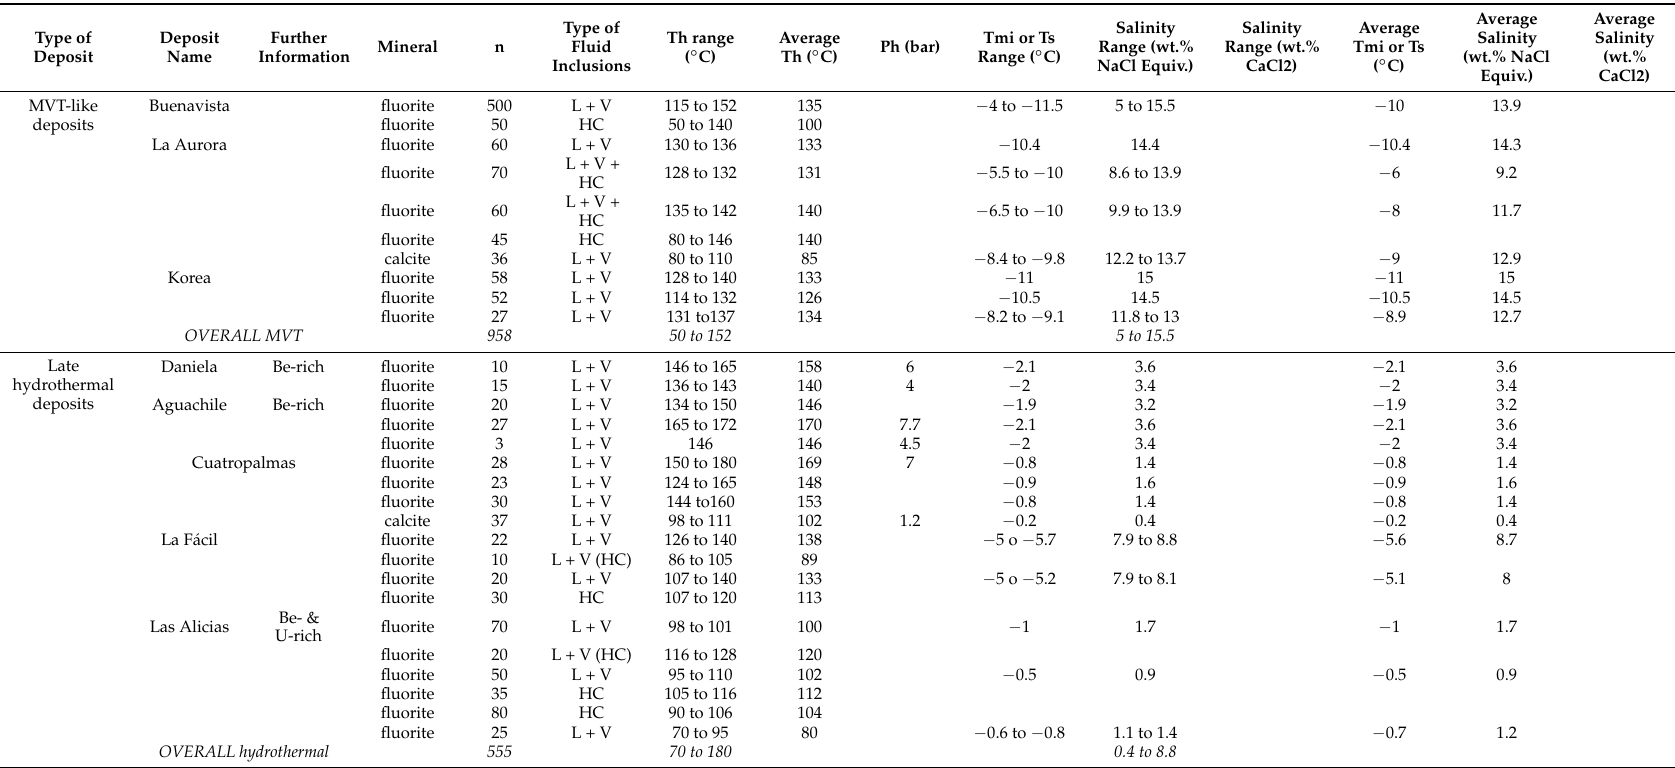
Table 1. Summary of fluid inclusion data from hydrothermal fluorite–Be–U–Mo–P–V deposits in the Aguachile–Cuatro Palmas area and from other types of fluorite deposits (for comparison) in northern Coahuila state, NE